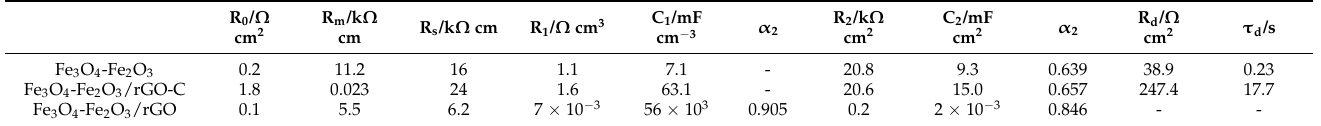
Table 1. Fitting parameter values obtained for the three systems investigated using the equivalent circuit depicted in Figure 4c. The thickness L of the nanostructured systems was fixed at 3.5 µ m. R 0 corresponds to the resistance of the electrolyte outside the sample, i.e., between the reference electrode and the surface of the sample, which depends on the position of the reference electrode with respect to the